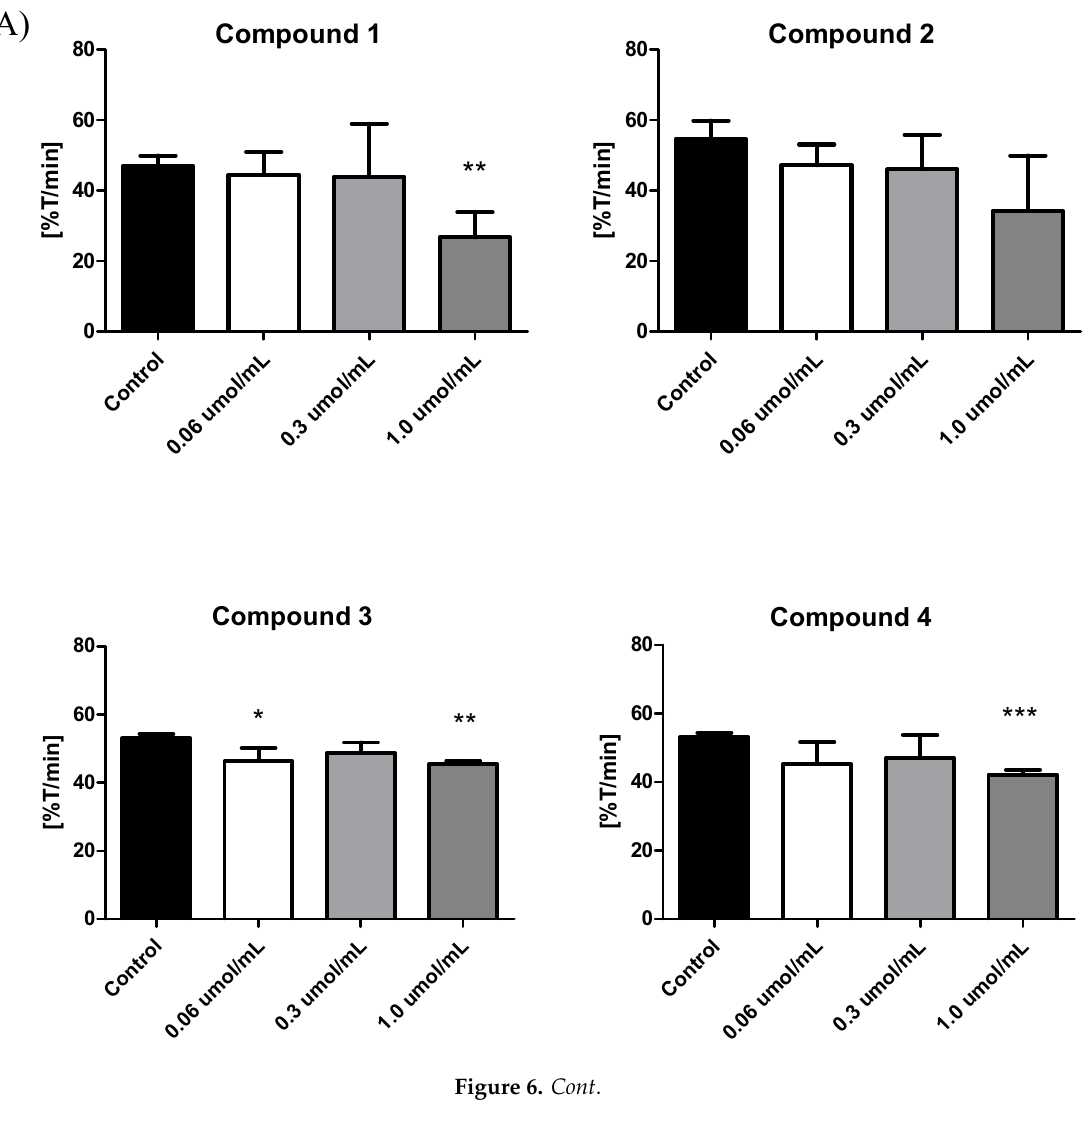
Figure 6. Cont Figure 6. Cont.